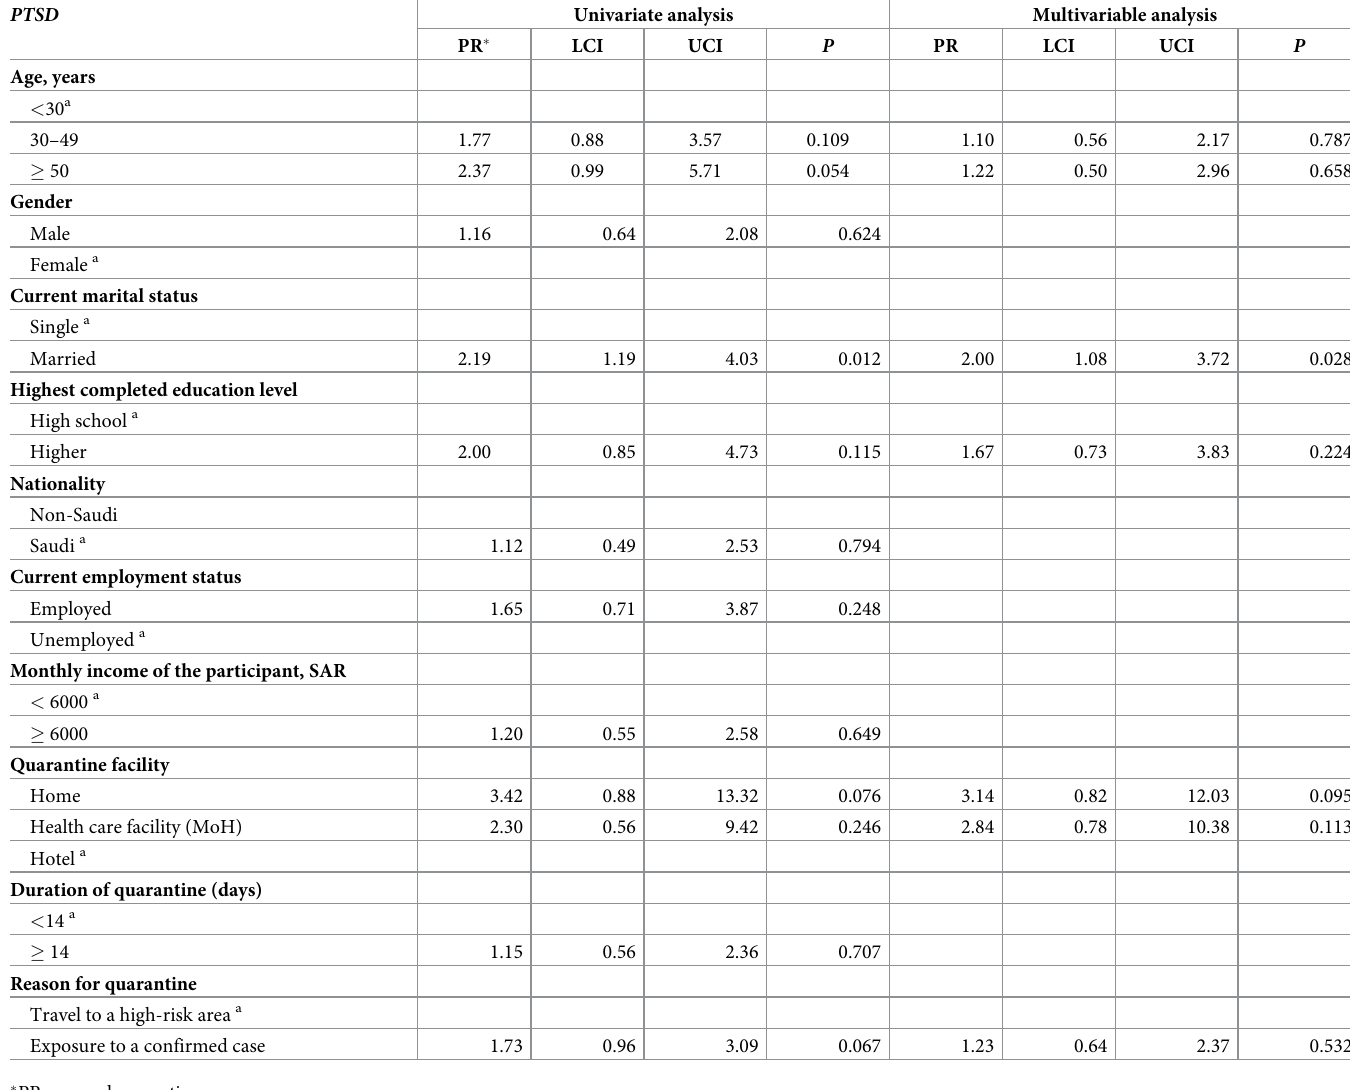
Table 3. Factors associated with post-traumatic stress disorder among survey participants (n =